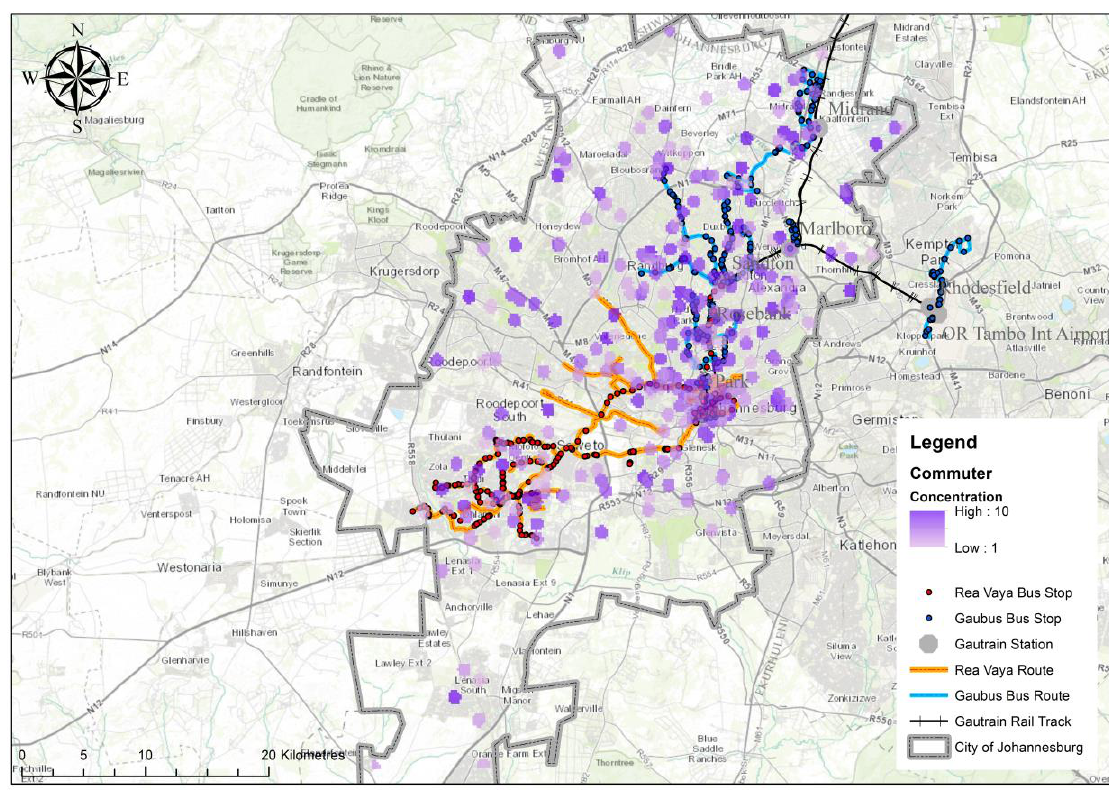
Figure 3. Commuter